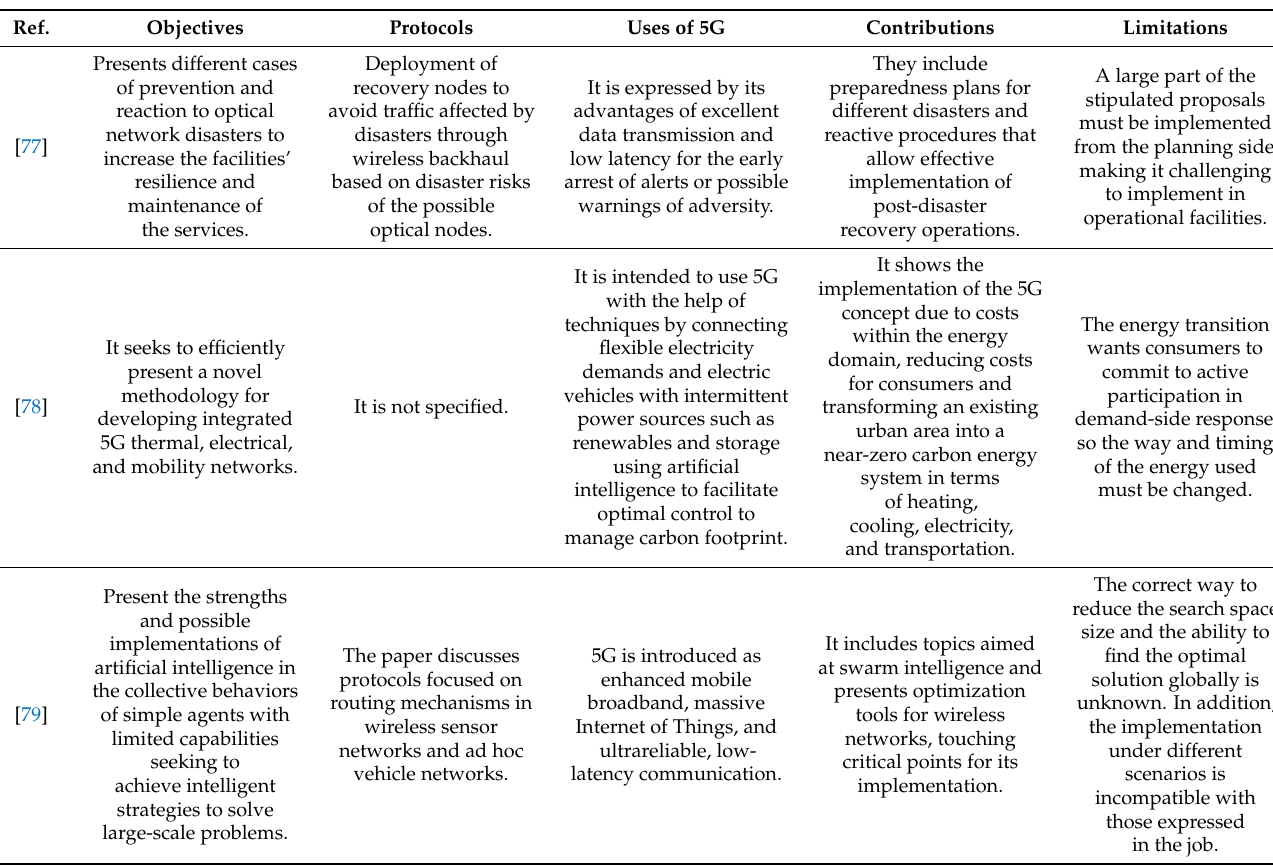
Table 2. Some microgrids use 5G for